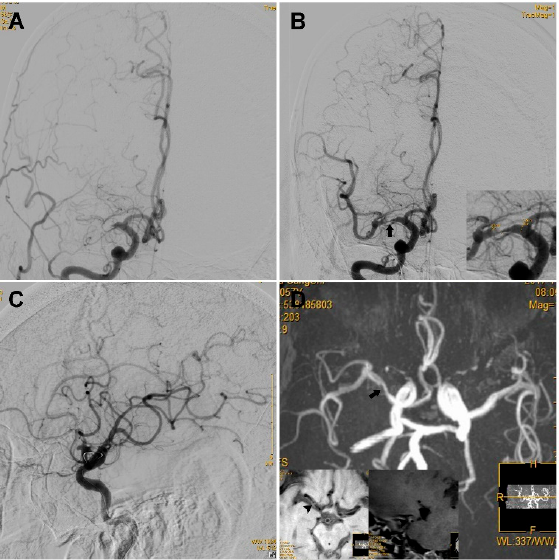
Figure 3. An ICAS case with a high degree of residual stenosis. An elderly patient presented with left limb weakness for 16 h, and the NIHSS score was 14. ( A ) The first run of DSA showed occlusion of the right MCA. ( B ) The anterior–posterior view of DSA showed a high degree of stenosis (black arrow) located at the right MCA after one pass of stent retrieval and emergent angioplasty via a 2.0–15 mm Maverick balloon; as the figure on the bottom right shows, the residual stenosis was 81.2% according to the WASID criteria. ( C ) Lateral view of the DSA showed that reperfusion with an mTICI of ≥ 2b was achieved and it was maintained for more than 20 min. ( D ). TOF-MRA performed 6 days after the operation showed a high degree of stenosis in the right MCA (black arrow). The high-resolution MRI scan on the bottom left showed an eccentric plaque (arrowhead) with enhanced stenosis that was observed at the right MCA. ICAS, intracranial atherosclerosis; NIHSS, National Institutes of Health Stroke Scale; DSA, digital subtraction angiography; MCA, middle cerebral artery; mTICI, modified thrombolysis in cerebral infarction; TOF-MRA, time of flight for magnetic resonance angiography; MRI, magnetic resonance imaging. Table 2. Baseline characteristics and clinical outcomes of patients in Step 2 of the analysis.